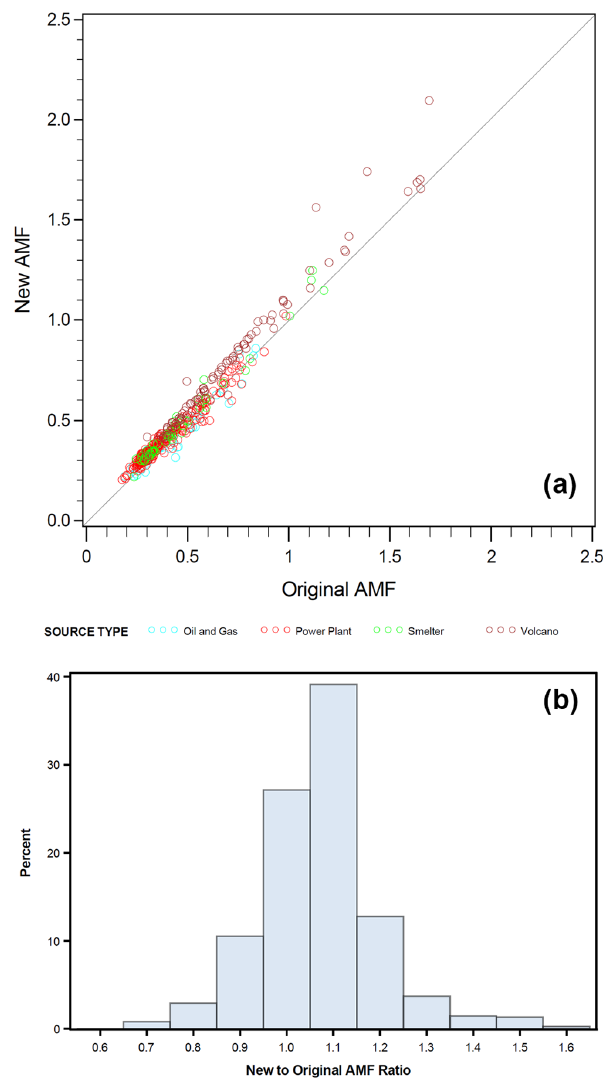
Figure 2. (a) Scatterplot of the AMFs used in the original catalogue vs. the AMFs used in the version 2 catalogue. Each dot corresponds to one emission source and the dot colour reflects the source type as shown in the legend. There are total of 555 sources on the plot. The correlation coefficient between the two datasets is 0.98. (b) The distribution of the ratio of the new AMF values to the AMF values in the original